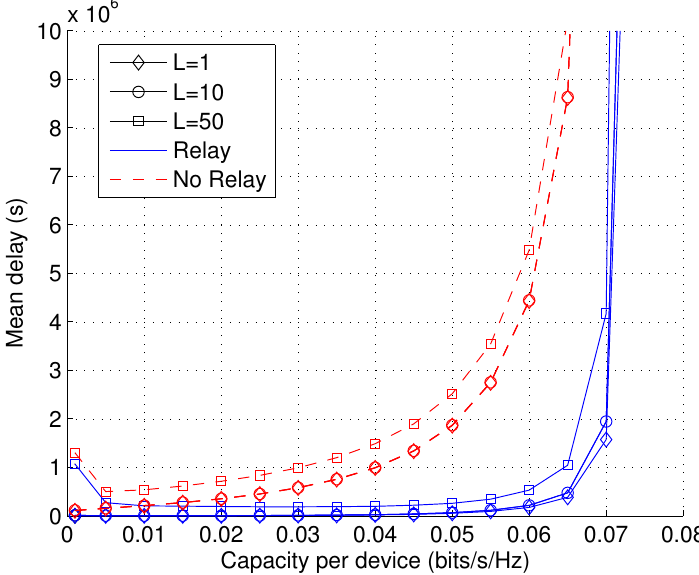
Figure 12. Mean delay ¯ D as a function of capacity per device C with varying packet size L ( P I = ∞ , P II = ∞ , λ b = 10 − 5 , arbitrary λ u , v = 1).